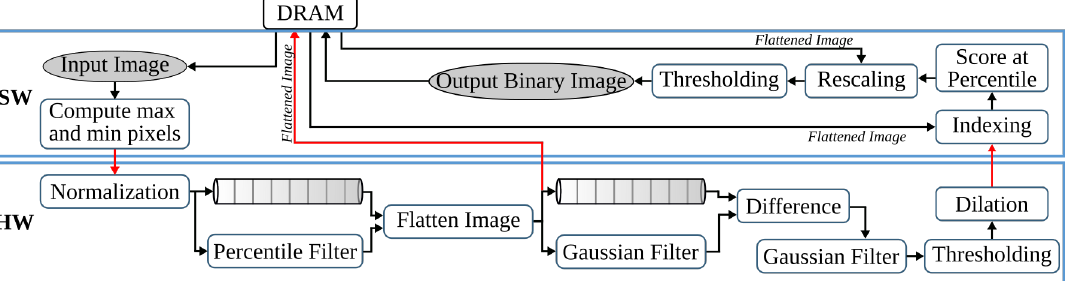
Figure 4. The system-level architecture of the i DocChip binarization